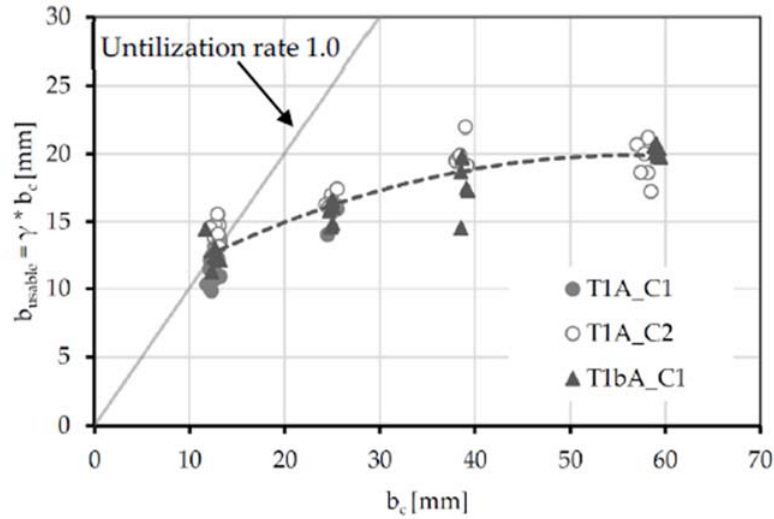
Figure 13. Relationship between the effective usable concrete width (b usable ) and concrete width per fiber strand (b c ).